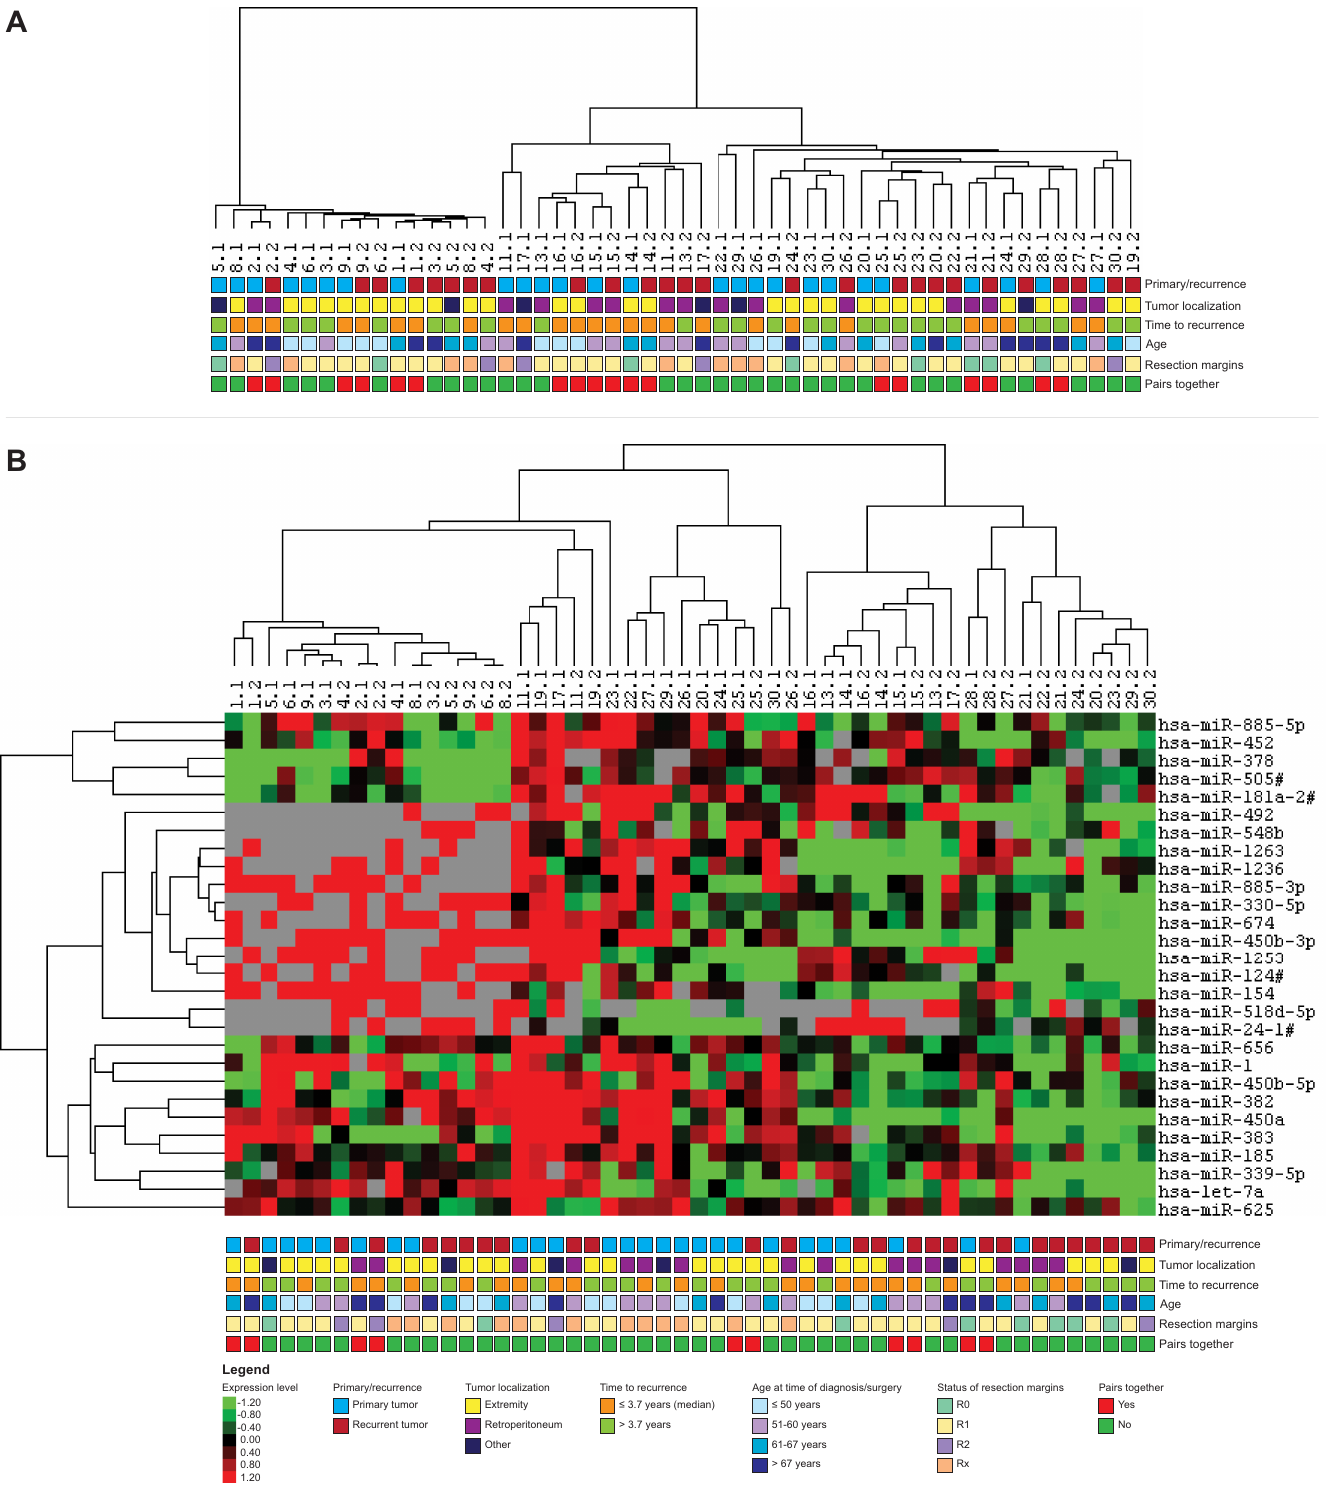
Fig 1. Hierarchical clustering based on the microRNA expression levels of 26 paired primary and recurrent WDLPS tumor samples. ( A ) Results of an unsupervised clustering analysis, depicted with time to recurrence, tumor localization, age and the status of the resection margins. Tumor pairs that cluster together in the same branch of the cluster tree are indicated with red boxes in the bottom line of the figure. ( B ) Results of a supervised clustering analysis based on the expression of